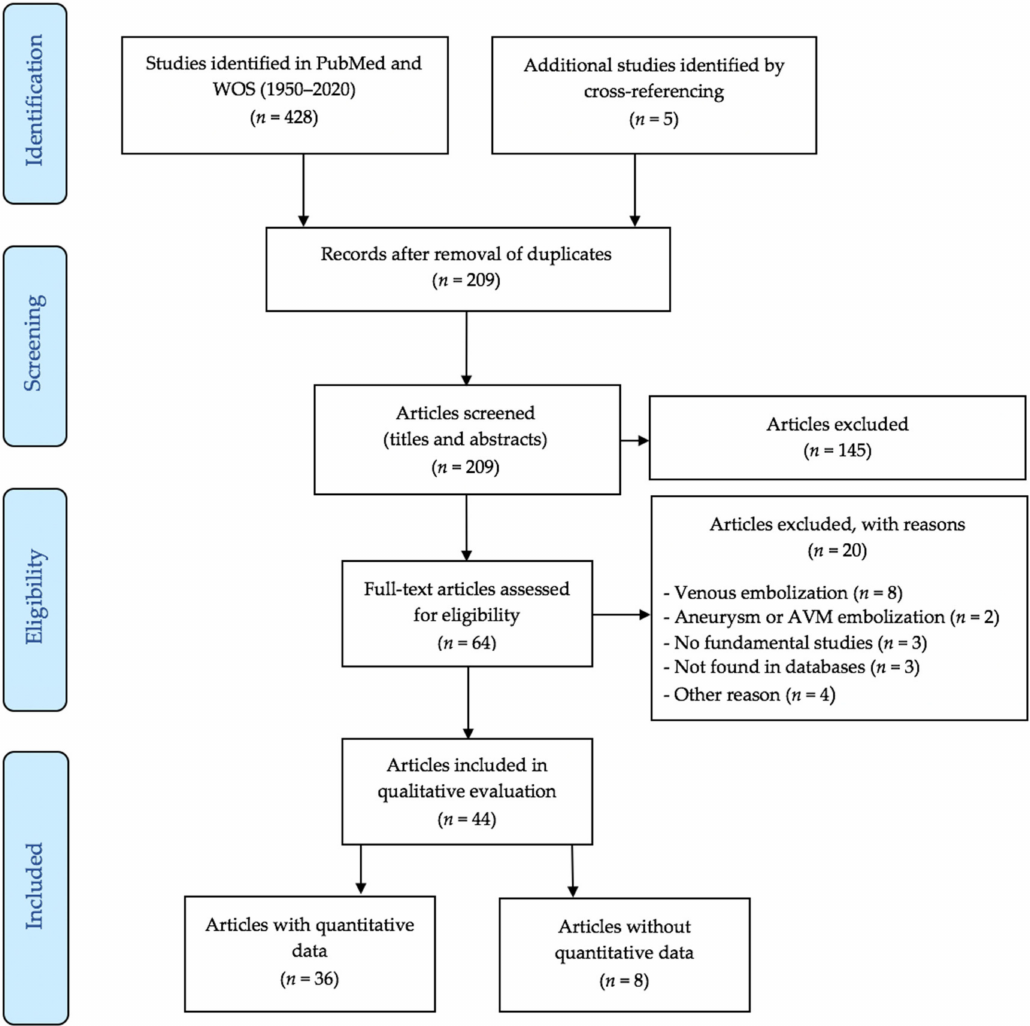
Figure 1. Flow chart. WOS, Web of Science; AVM, arteriovenous